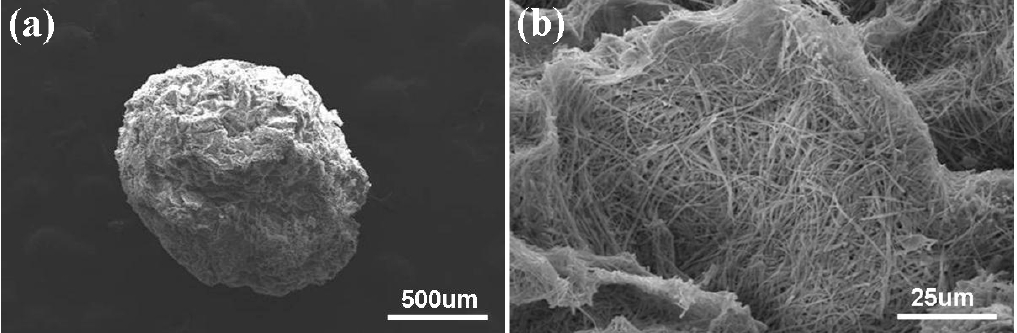
Figure 4. SEM images of a MFB surface in different magnifications ( a ) ×50, scale bar = 500 µm and ( b ) ×1000, scale bar = 25 µm.